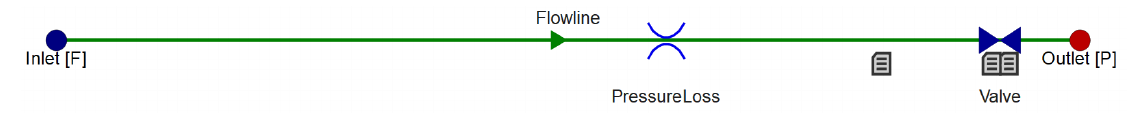
Figure 4. LedaFlow setup.